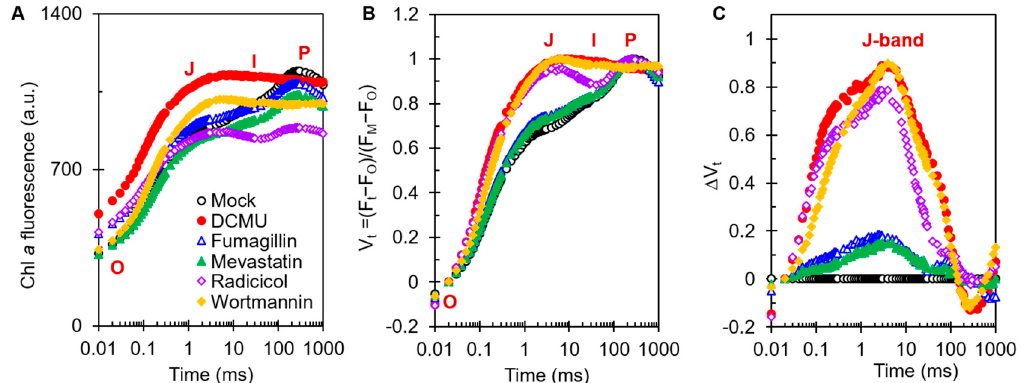
Figure 4. Effects of four mycotoxins and DCMU on Chl a fluorescence rise kinetics of C. reinhardtii cells. Cells after 3 h of treatment with 0.1 % DMSO (mock), 50 μ M DCMU, 50 μ M fumagillin, 200 μ M mevastatin, 500 μ M radicicol, or 500 μ M wortmannin. ( A ) Raw fluorescence rise OJIP curves of mock-, DCMU-, fumagillin-, mevastatin-, radicicol-, and wortmannin-treated C. reinhardtii cells. ( B ) Chl a fluorescence rise kinetics normalized by F O and F M as V t = (F t − F O )/(F M − F O ) versus logarithmic timescale. ( C ) The difference kinetics ∆ V t = V t(treatment) − V t(mock) versus logarithmic timescale. Each curve is the average of 30 measurements.